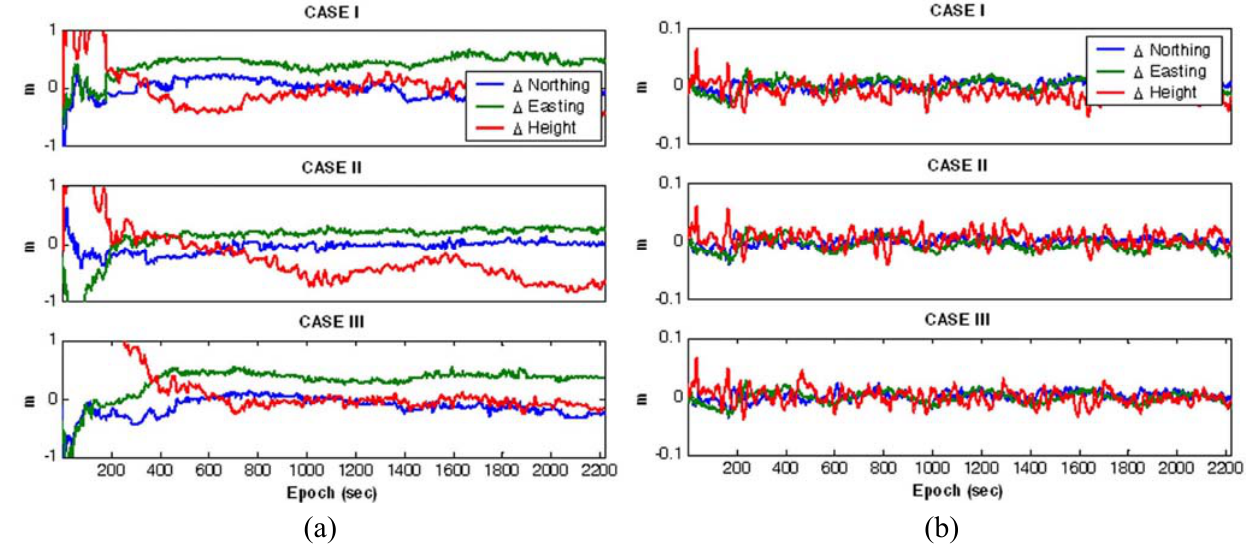
Figure 10. Coordinate differences between the references and estimates. (a) Single-reference station mode. (b) Multiple-reference stations mode.